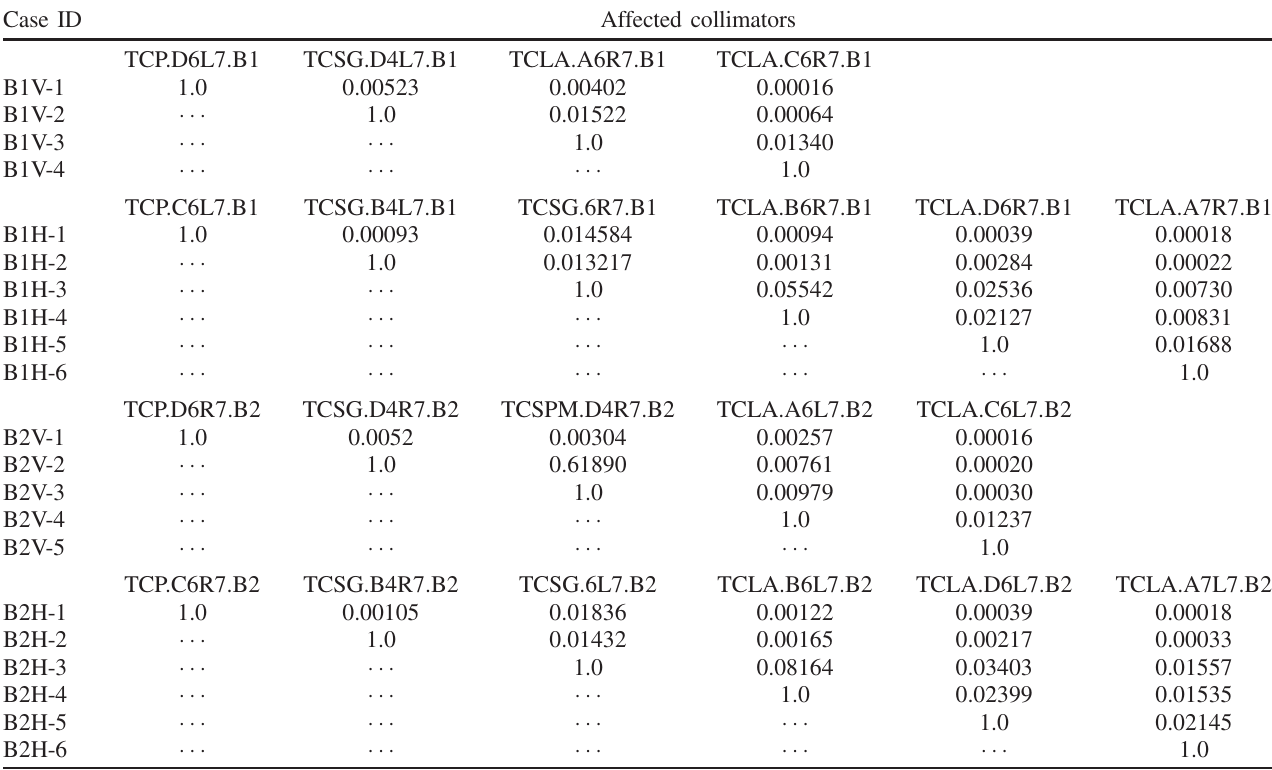
TABLE VI. BLM cross-talk factors calculated from the individual cases during LHC beam tests. Case